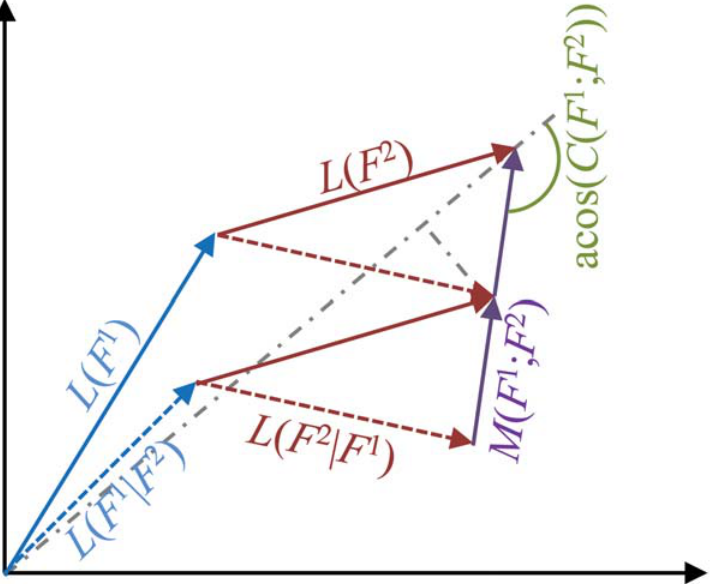
Fig 2. (Conditional) layer dynamics, mutual dynamics, incompatibility, and cooperativity. The joint dynamics L ( F 1 , F 2 ) is equal to the sum of the isolated dynamics L ( F 1 ) [solid blue] and the conditional dynamics L ( F 2 j F 1 ) [dashed red], or vice versa L ( F 2 ) + L ( F 1 j F 2 ) [solid red and dashed blue]. The mutual dynamics M ( F 1 ; F 2 ) [solid lilac] corresponds to the error made when approximating the joint dynamics L ( F 1 , F 2 ) with the sum of isolated dynamics L ( F 1 ) + L ( F 2 ). The cooperativity C ( F 1 ; F 2 ) is the cosine of the angle between − M and the sum of the isolated dynamics. In the example shown, the cooperativity is negative, indicating that the isolated behaviour L ( F 1 ) + L ( F 2 ) is attenuated when F 1 and F 2 are integrated together, although also with some orthogonal effects. The strength of their interaction is proportional to the incompatibility I ( F 1 ; F 2 ), defined as the ratio between the lengths of M ( F 1 ; F 2 ) and L ( F 1 ) + L ( F 2